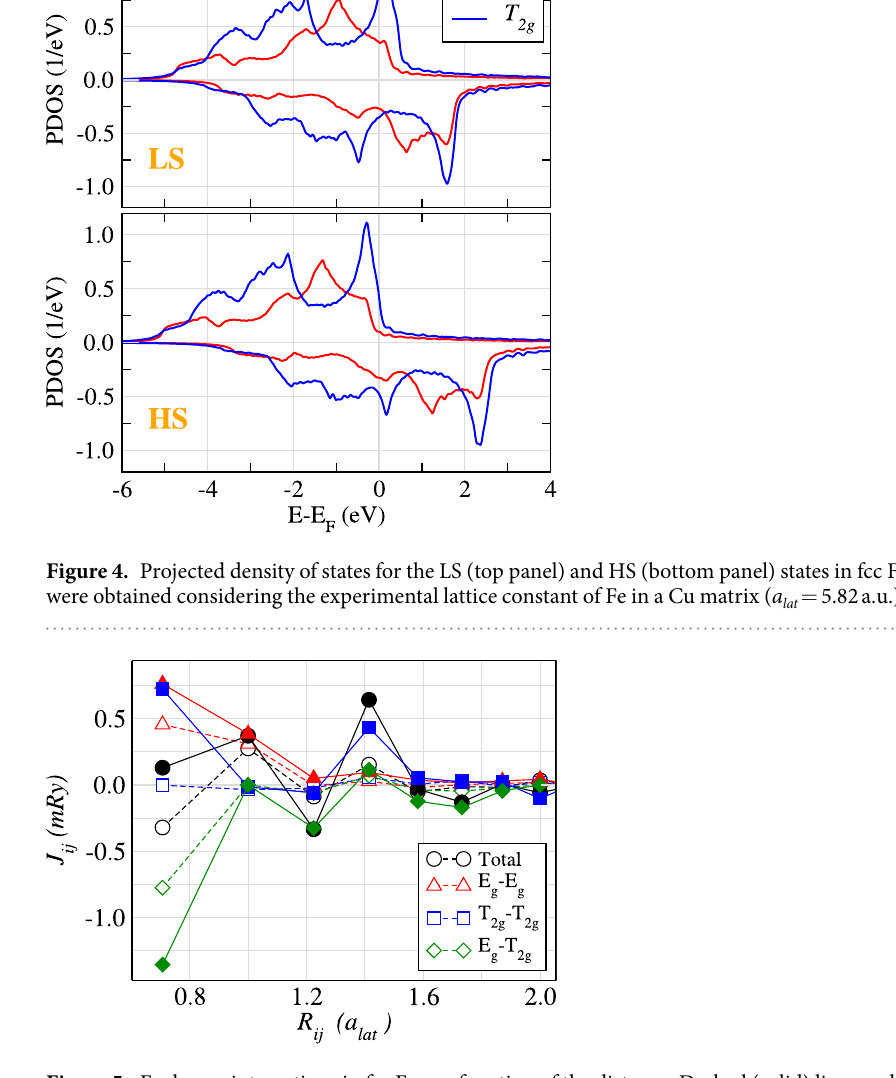
Figure 5. Exchange interactions in fcc Fe as a function of the distance. Dashed (solid) lines and open (filled) symbols correspond to LS (HS)